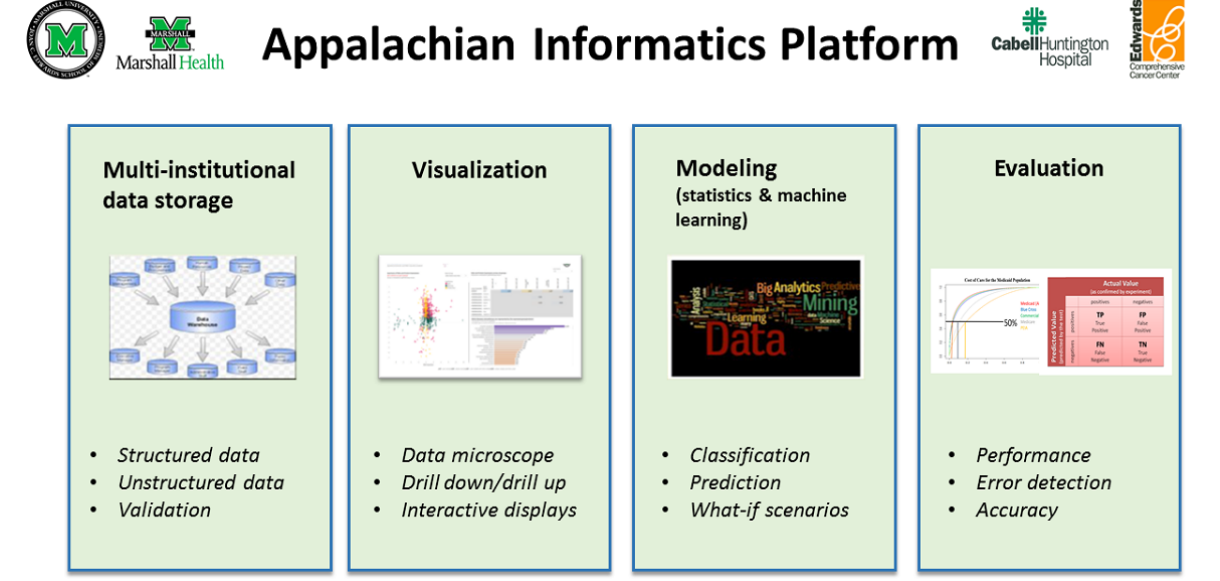
Figure 1. Components of the Appalachian Informatics